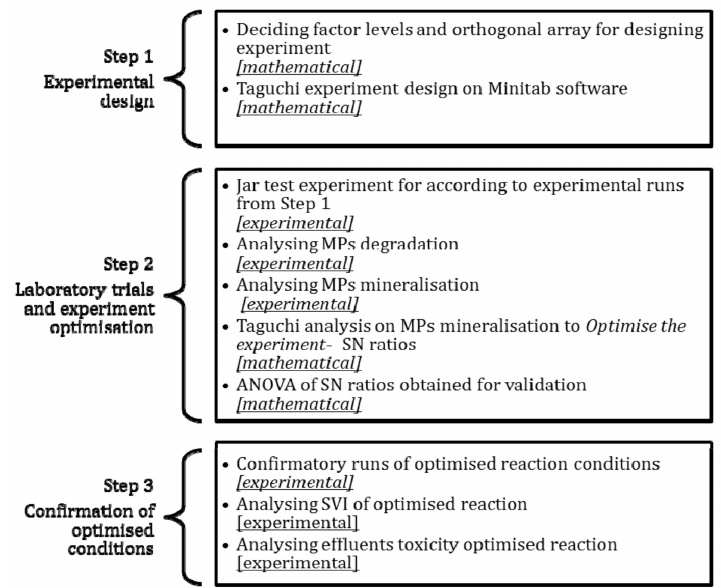
Figure 1. Schematic layout of the